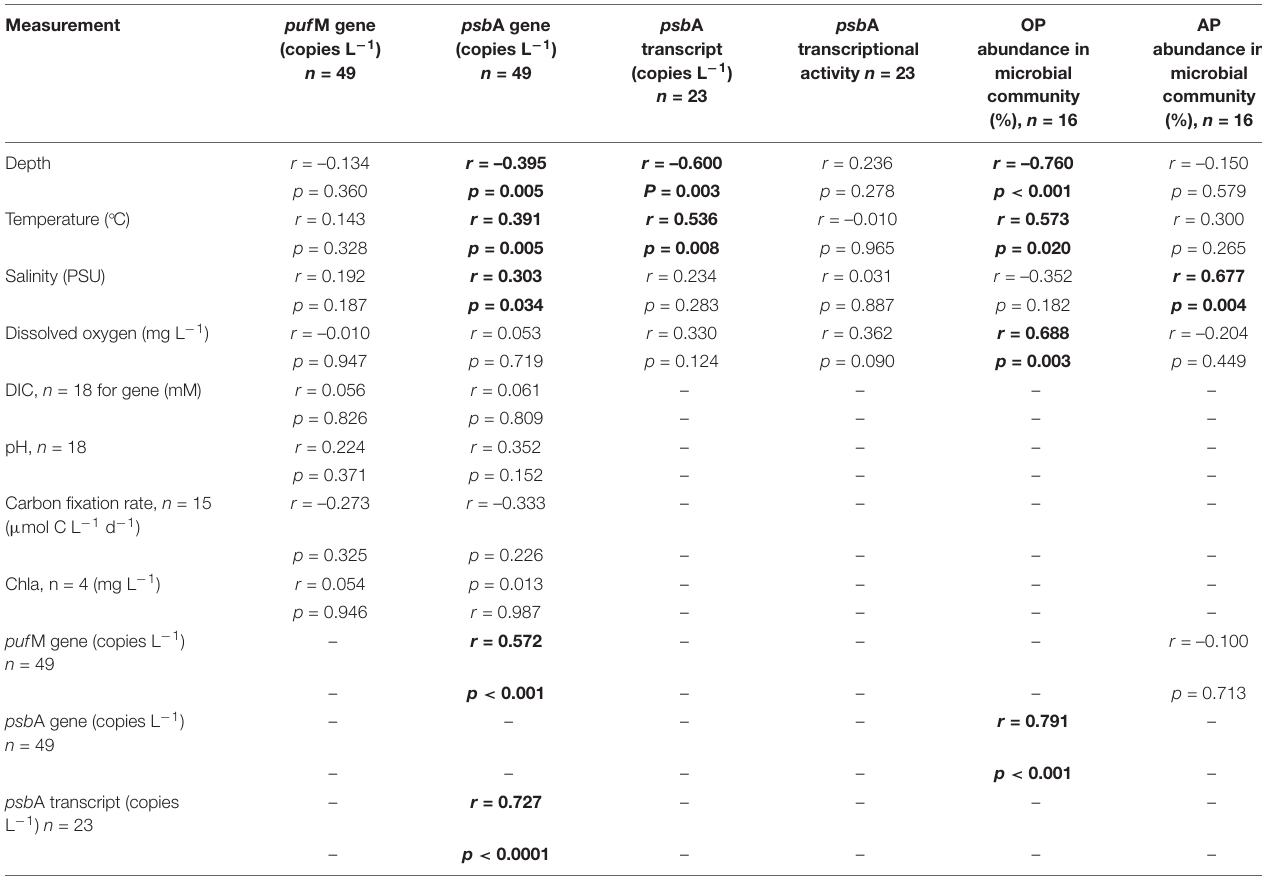
TABLE 3 | Pearson correlations of the gene abundance, transcript abundance, and transcriptional activity of puf M and psb A with environmental variables, carbon fixation rate, and OP or AP abundance in microbial community.